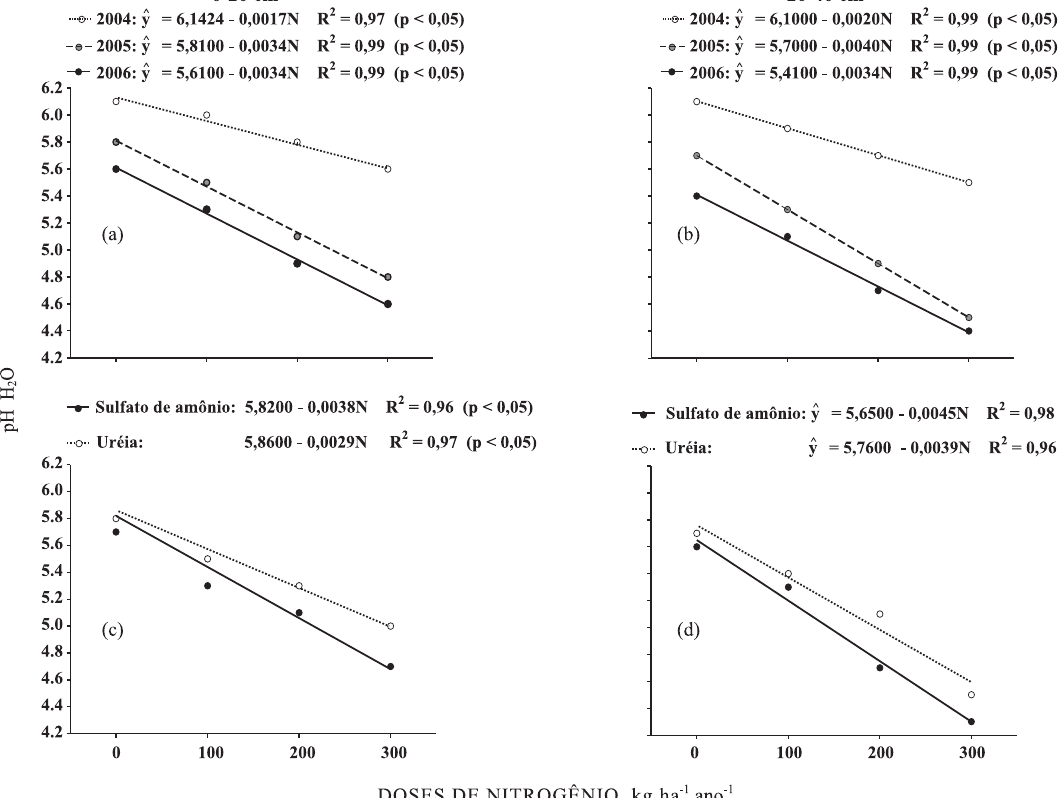
Figura 1. Efeito de doses e de fontes de nitrogênio sobre o pH do solo avaliado em diferentes épocas, nas camadas de 0–20 e 20–40 cm de